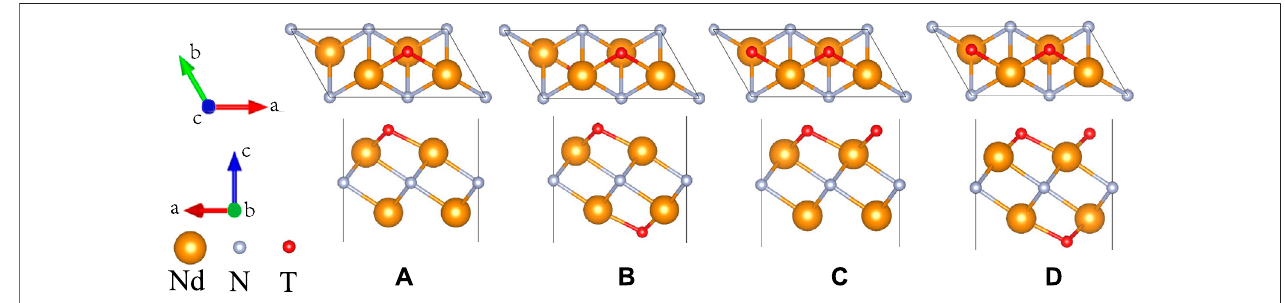
FIGURE 7 | Top and side views of the 2 × 1×1 supercell of the structure of the two-dimensional MXene material Nd 2 NT x (T = OH, O, F; x = 0.5, 1, and 1.5). (A) Nd